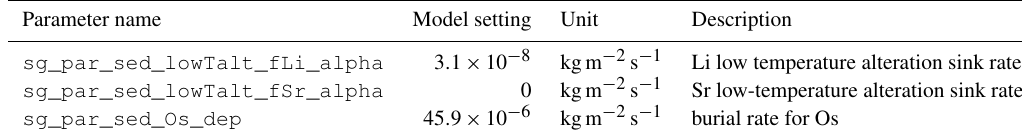
Table E7. Model parameters for metal deposition in sediments.